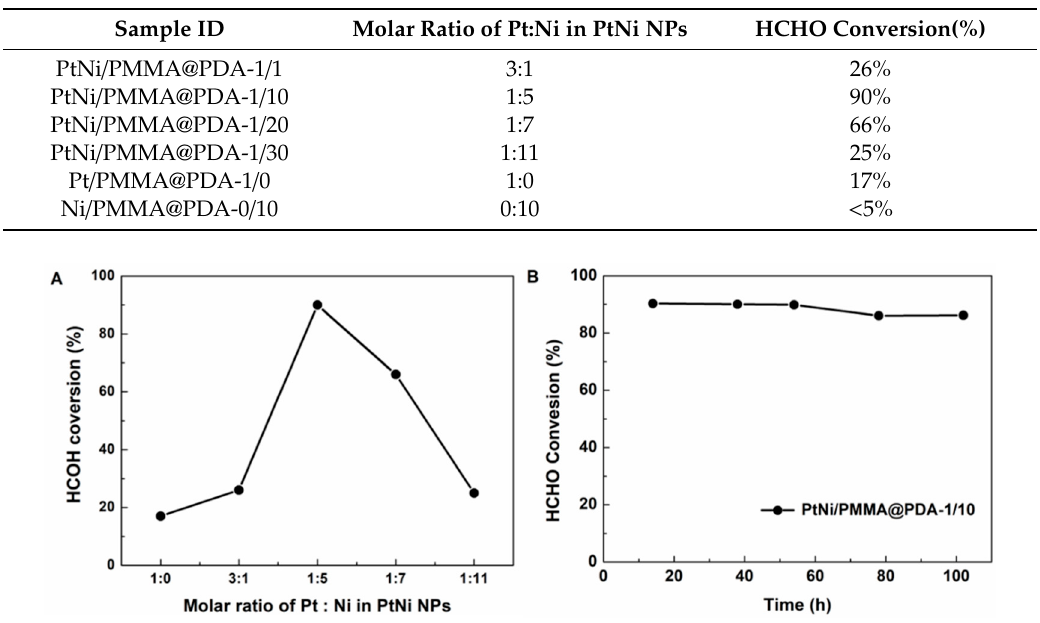
Table 2. HCHO conversion over the catalytic membrane with different PtNi NP compositions.